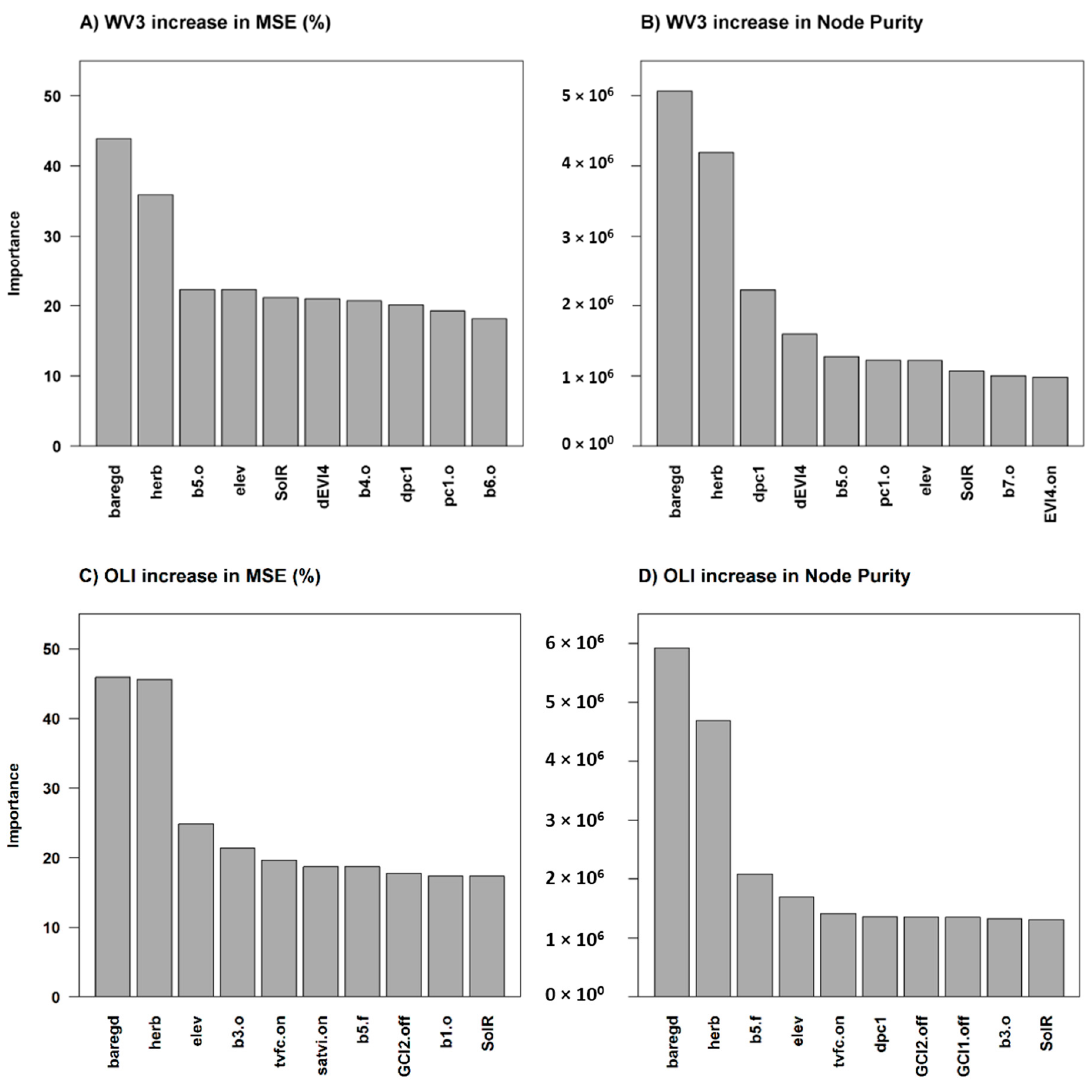
Figure 9. Variable importance plots for biomass model developed from ( A , B ) Worldview-3 and ( C , D ) Operational Land Imager top 10 satellite image bands, vegetation indices, terrain and vegetation cover variables. The increase in MSE (%) and node purity with a predictor variable held out of model training for n = 2000 regression trees was used as an indicator of each variables importance. Greater importance values suggested which variables had the greatest explanatory power in the model.